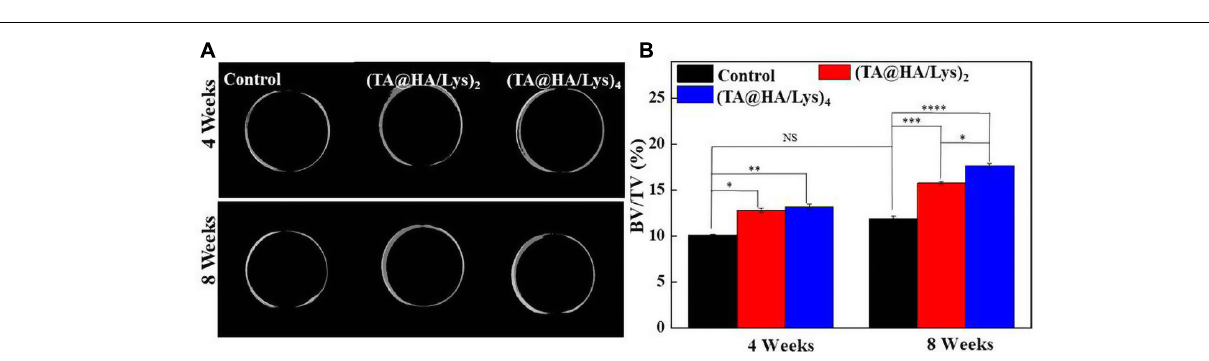
FIGURE 10 | (A) Bone regeneration images in the rabbit femur were reconstructed by the CT-Volume (CTVol) software in three-dimensional (3D) model, when titanium rods with a blank layer as control, (TA@HA/Lys) 2 and (TA@HA/Lys) 4 coatings implanted for 4 (top) and 8 weeks (bottom). (B) Bone volume (BV) fraction [BV/total volume (TV)] of control, (TA@HA/Lys) 2 and (TA@HA/Lys) 4 coatings group. * p < 0.05, ** p < 0.01, *** p < 0.001, **** p <